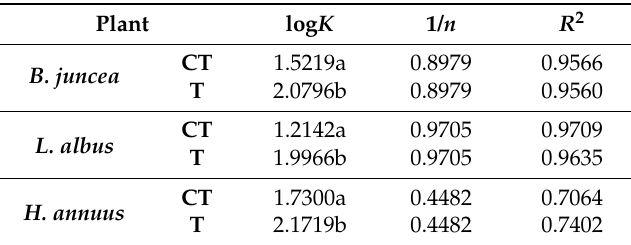
Table 5. Relationship between root uptake and potentially available concentration of As in soil. Parameters of the Freundlich-like model by setting 1/ n as shared